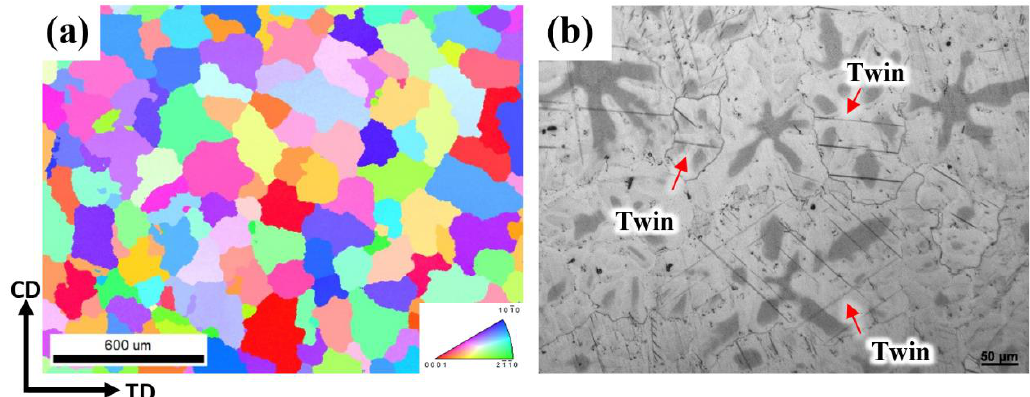
Figure 8. ( a )The IPF map and ( b ) metallography at